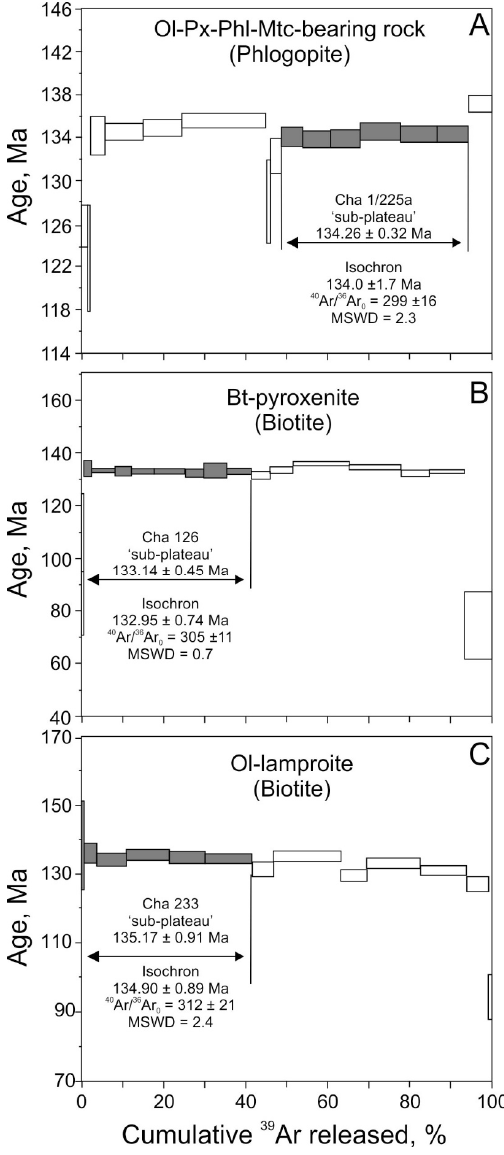
Figure 5. Argon release spectra for the early stage intrusions: ( A ) Sample Cha1/225a—cumulative olivine-pyroxene-phlogopite-monticellite rock; ( B ) sample Cha126—biotite-pyroxenite; and ( C ) sample Cha233—olivine lamproite. Steps used for calculation of sub-plateau and isochron age values are shadowed.